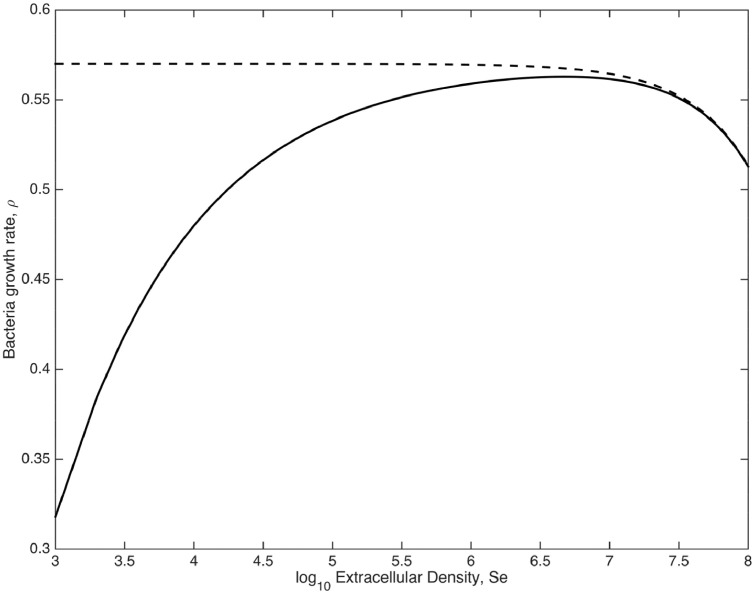
The per-capita growth rate, ρ, Eq. (9), of extracellular bacteria, with values set as the mean from the posterior distributions in Fig. 2. In particular pβ=0.557 (solid line). For comparison pβ=1 (dashed) is also shown.